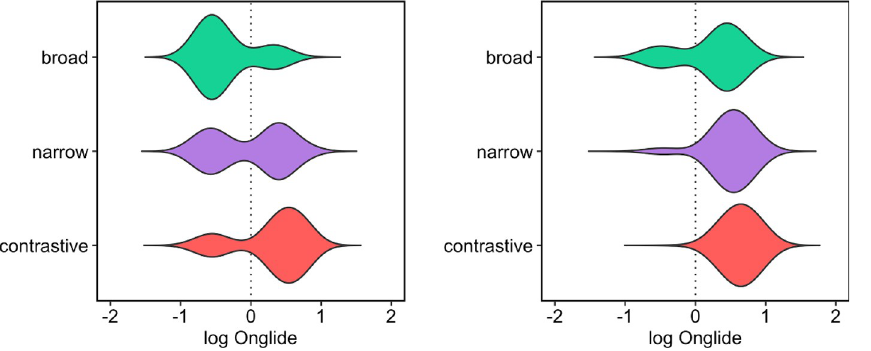
Fig 17. Onglide distributions of group 1 (left) and group 2